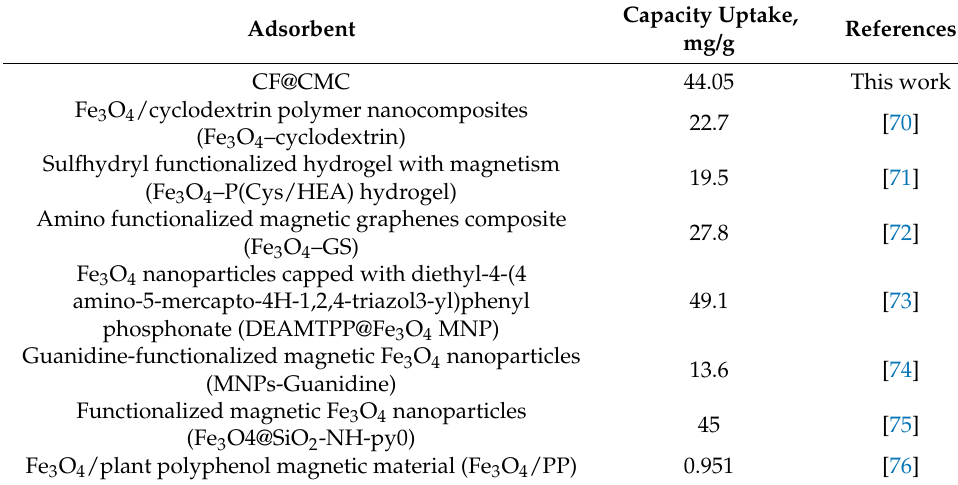
Table 2. Comparison of maximum Cd (II) capacity uptake of different adsorbents reported in